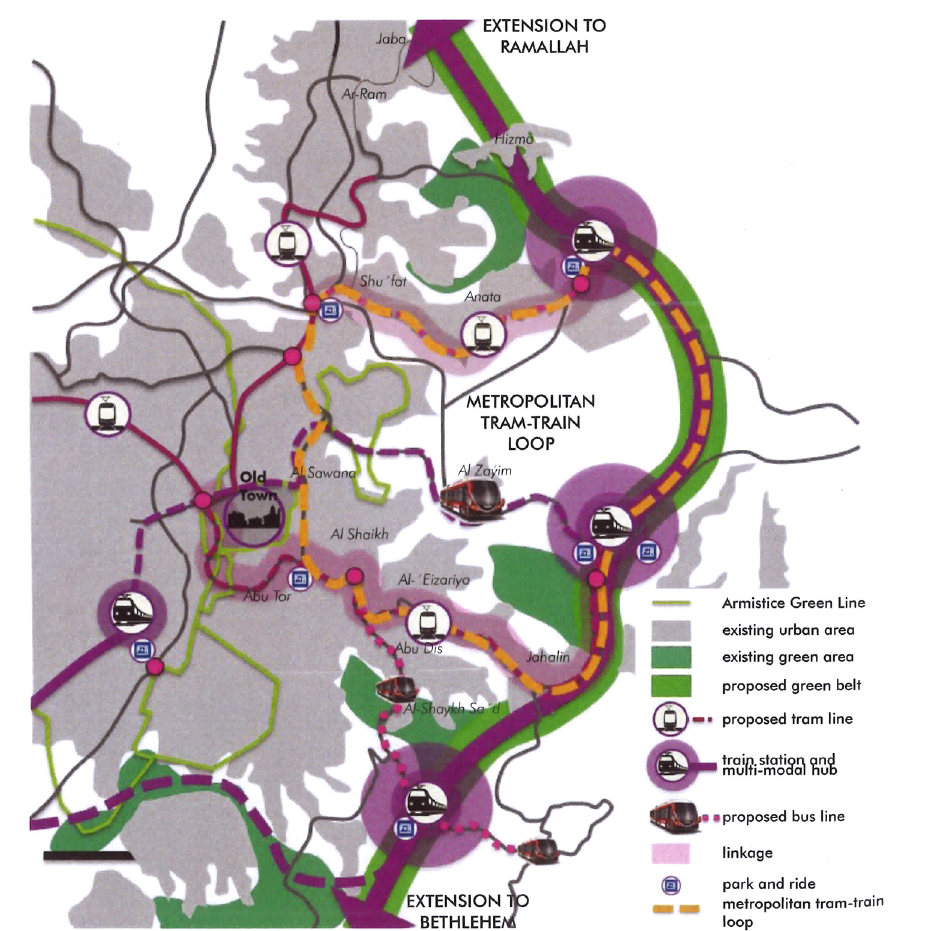
Figure 6. Vision for the metropolitan region Ramallah, Jerusalem and Bethlehem integrating sustainable mobility and urban development (Goethals,